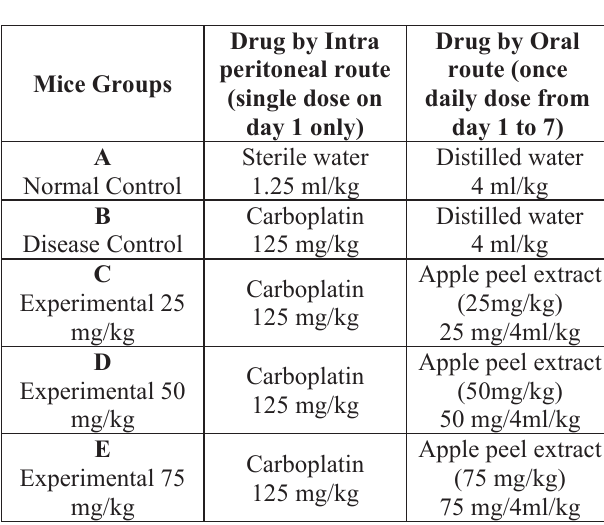
Table-1: Summary of drugs administered to all groups Sampling Technique & Analyzed